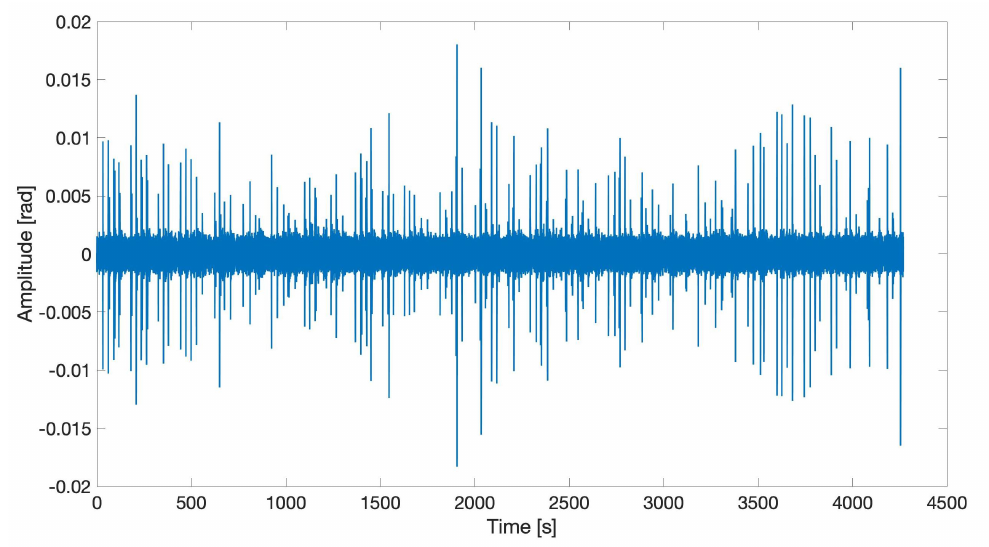
Figure 10. Example of a burst of AE signals detected by the FOS sensor during fatigue crack growth